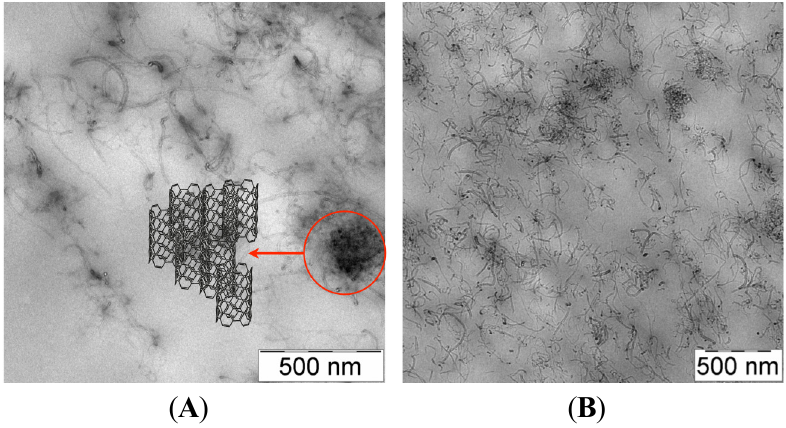
Figure 22. TEM micrographs of MWCNT/polymer blends. ( A ) unexfoliated MWCNT agglomerates; ( B ) an uniformly dispersed composite. Adapted from Panariello